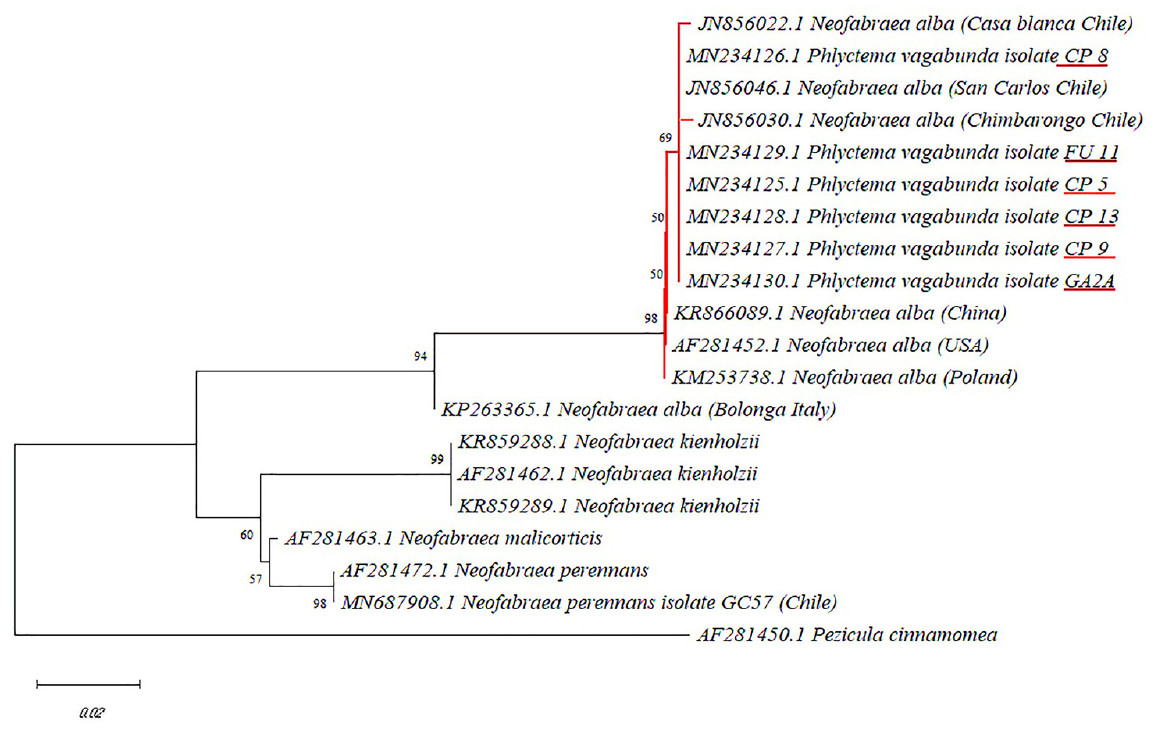
Figure 1. Phylogenic tree showing the relationships between Neofabraea spp. isolates published in GenBank and the isolates obtained in this study (CP5, CP8, CP9, CP13, FU11, and GA2A), inferred by the neighbor-joining method based on the partial sequencing of the β -tubulin gene. Pezicula cinnamomea was used as an outgroup.